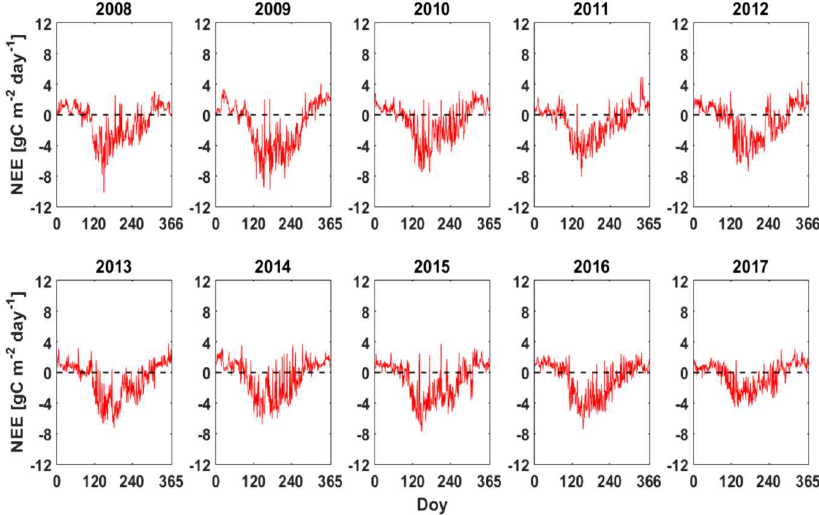
− 2 day − 1 ) in Jastrebarsko forest, Figure 5. Daily sums of NEE (gC m −2 day −1 ) in Jastrebarsko forest, 2008–2017. Figure 5. Daily sums of NEE (gC m